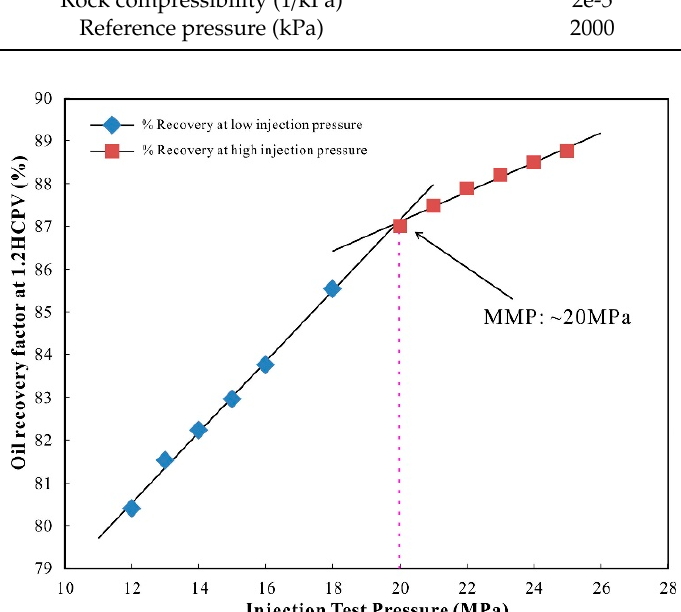
Figure 3. Oil recovery factor at 1.2 hydrocarbon pore volume (HCPV) versus injection test pressure of CO 2 flooding for slim tube numerical simulations showing MMP estimated at approximately 20 MPa.